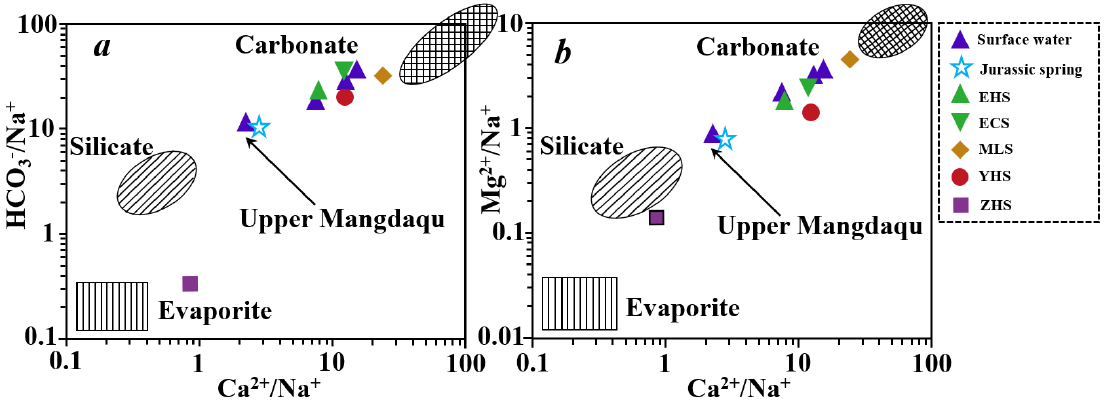
Figure 5. Relationships of ( a ) HCO 3 − /Na + and Ca 2+ /Na + ; ( b ) Mg 2+ /Na + and Ca 2+ /Na + .